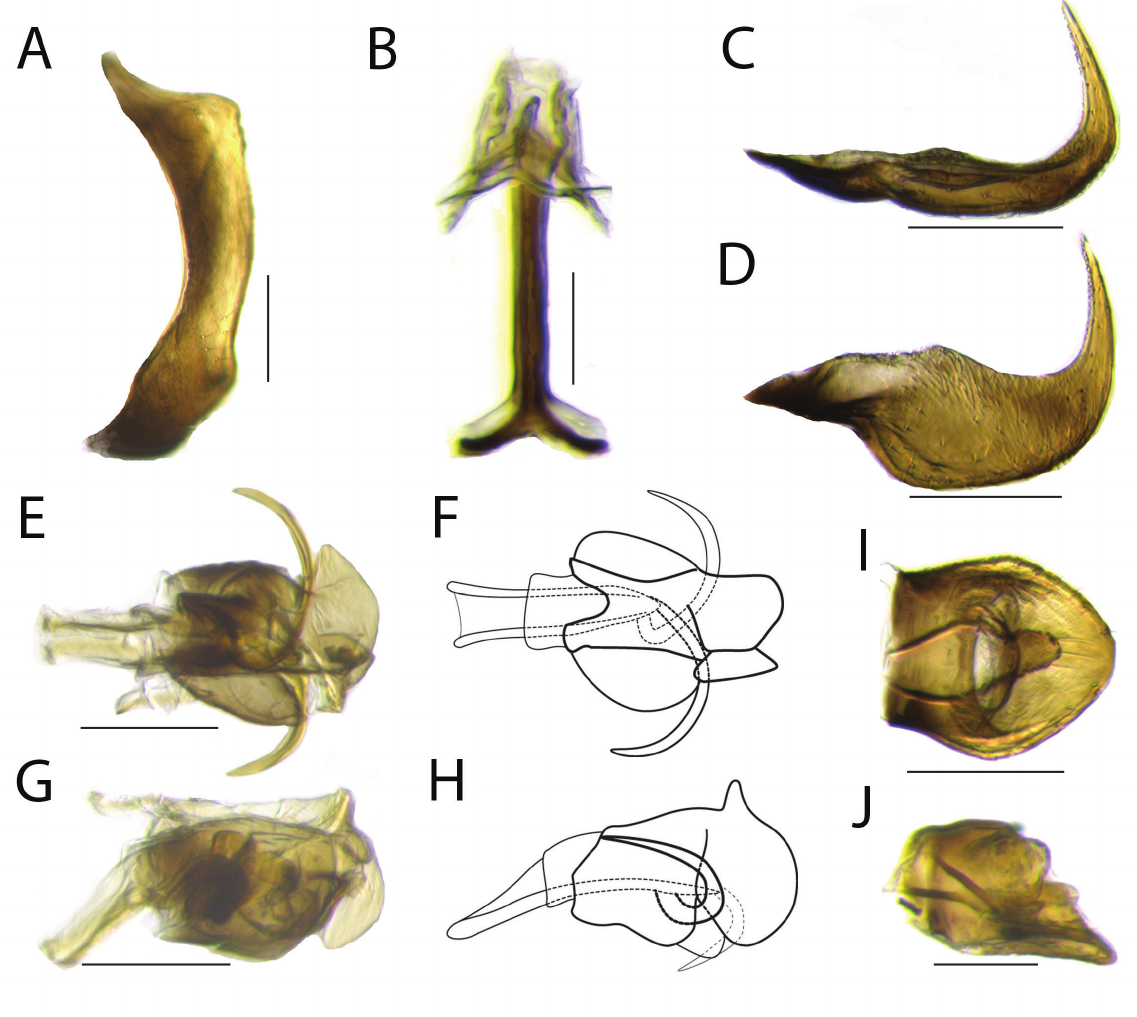
Fig. 19. Male terminalia structures of Protrocha nesolitaria (Caldwell, 1945) (INHS). A . Pygofer, lateral view. B . Connective, anterior view. C–D . Style. C . Dorsal view. D . Lateral view. E–H . Phallus. E–F . Dorsal view. G–H . Lateral view. I–J . Anal tube. I . Dorsal view. J . Lateral view. Scale bars = 0.1